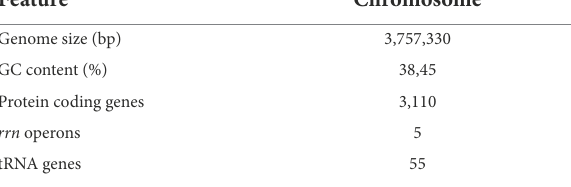
TABLE 1 General features of the Anaeropeptidivorans aminofermentans M3/9 T genome.